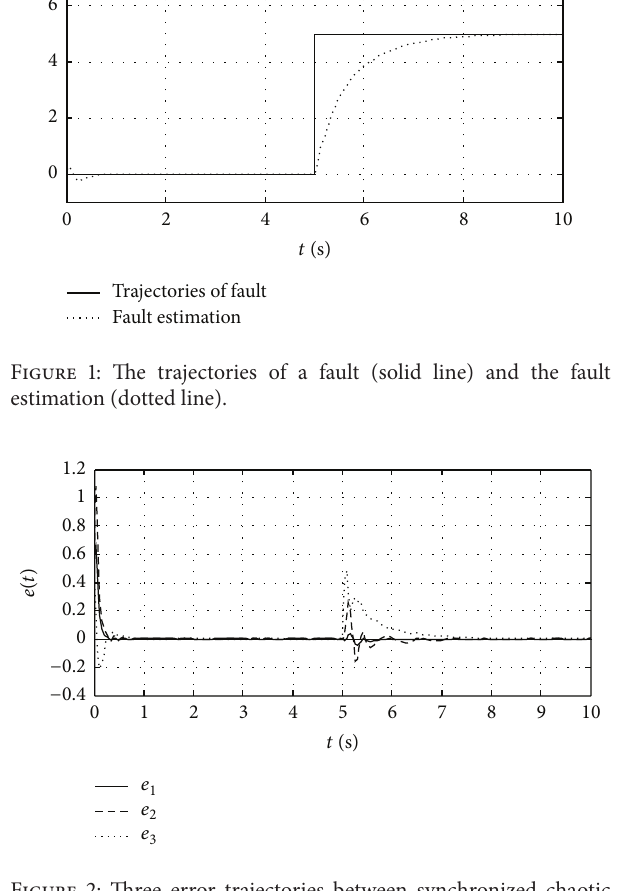
Figure 2: Three error trajectories between synchronized chaotic systems.